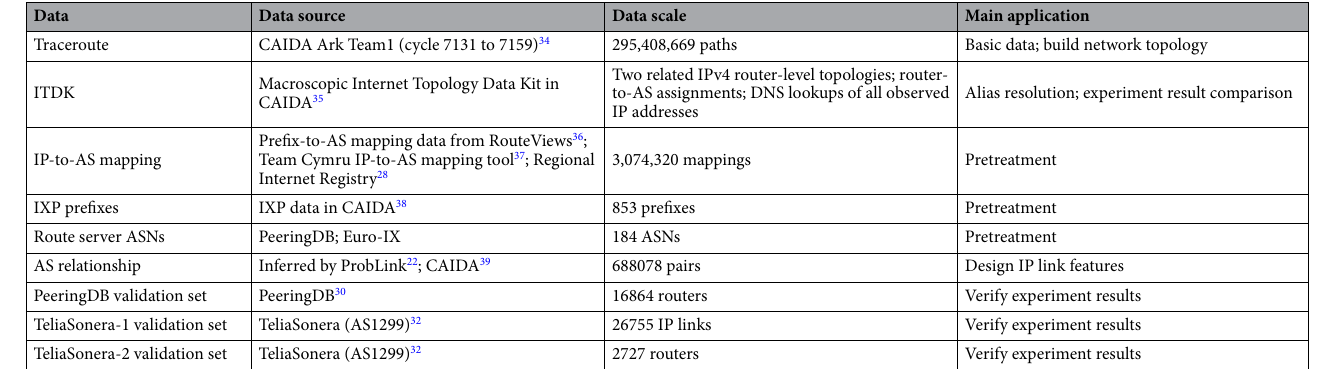
Table 4. The data sources, data scales, and main applications in the experiment.